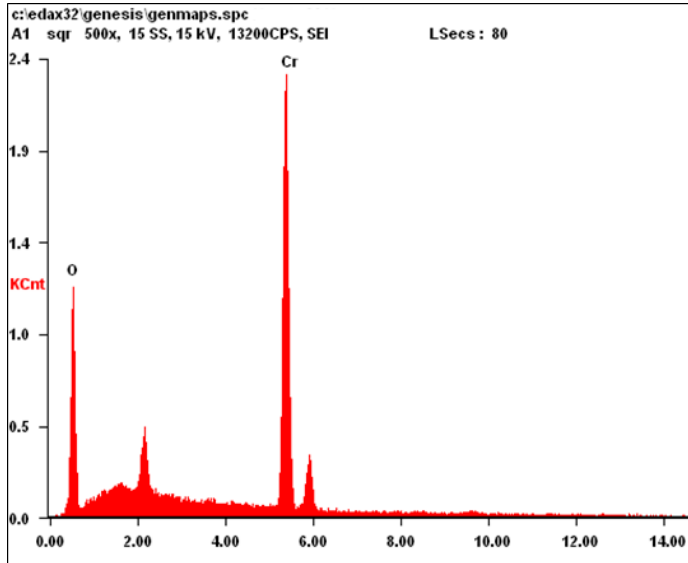
Figure 1. Composition samples by EDS.